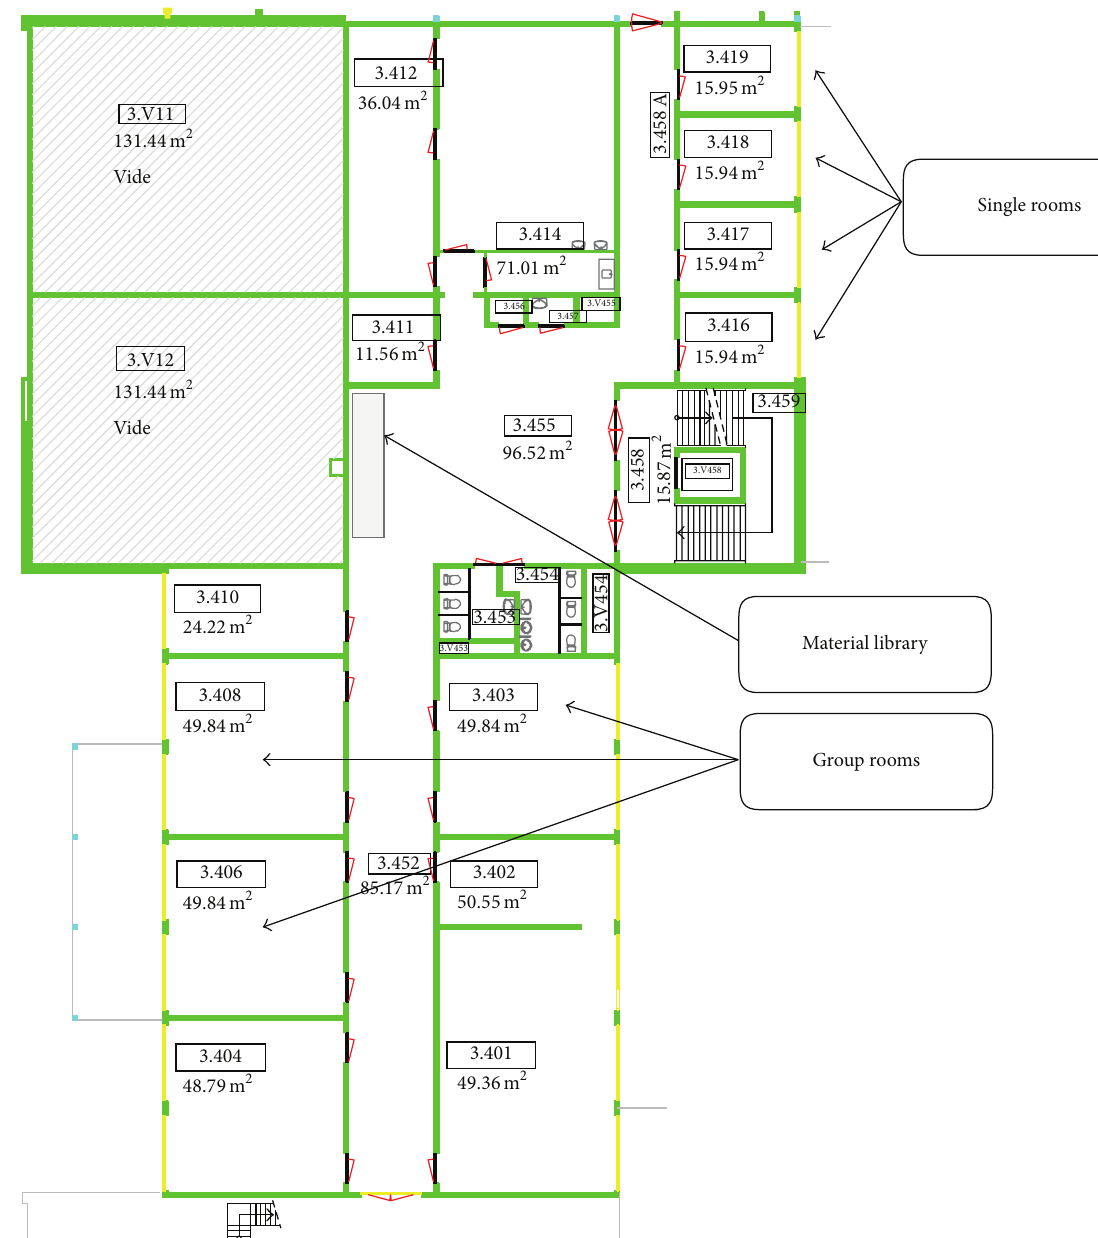
Figure 1: Layout of the rooms at the Fontys School of People and Health Studies, Eindhoven, in which the sessions took place.